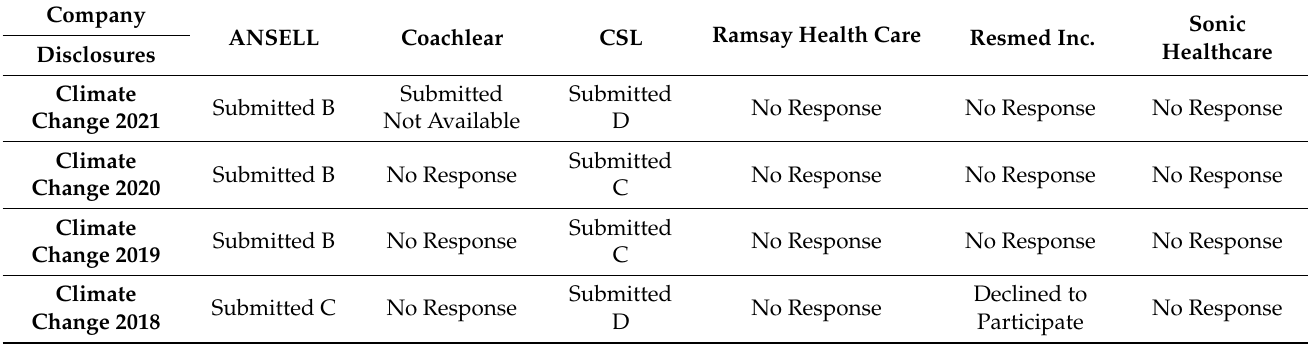
Table 1. ASX100 healthcare companies’ disclosures and